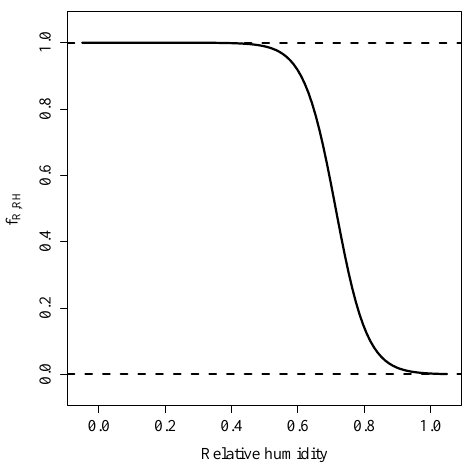
Fig. 1. Function describing the influence of temperature on the re- lease of birch pollen.